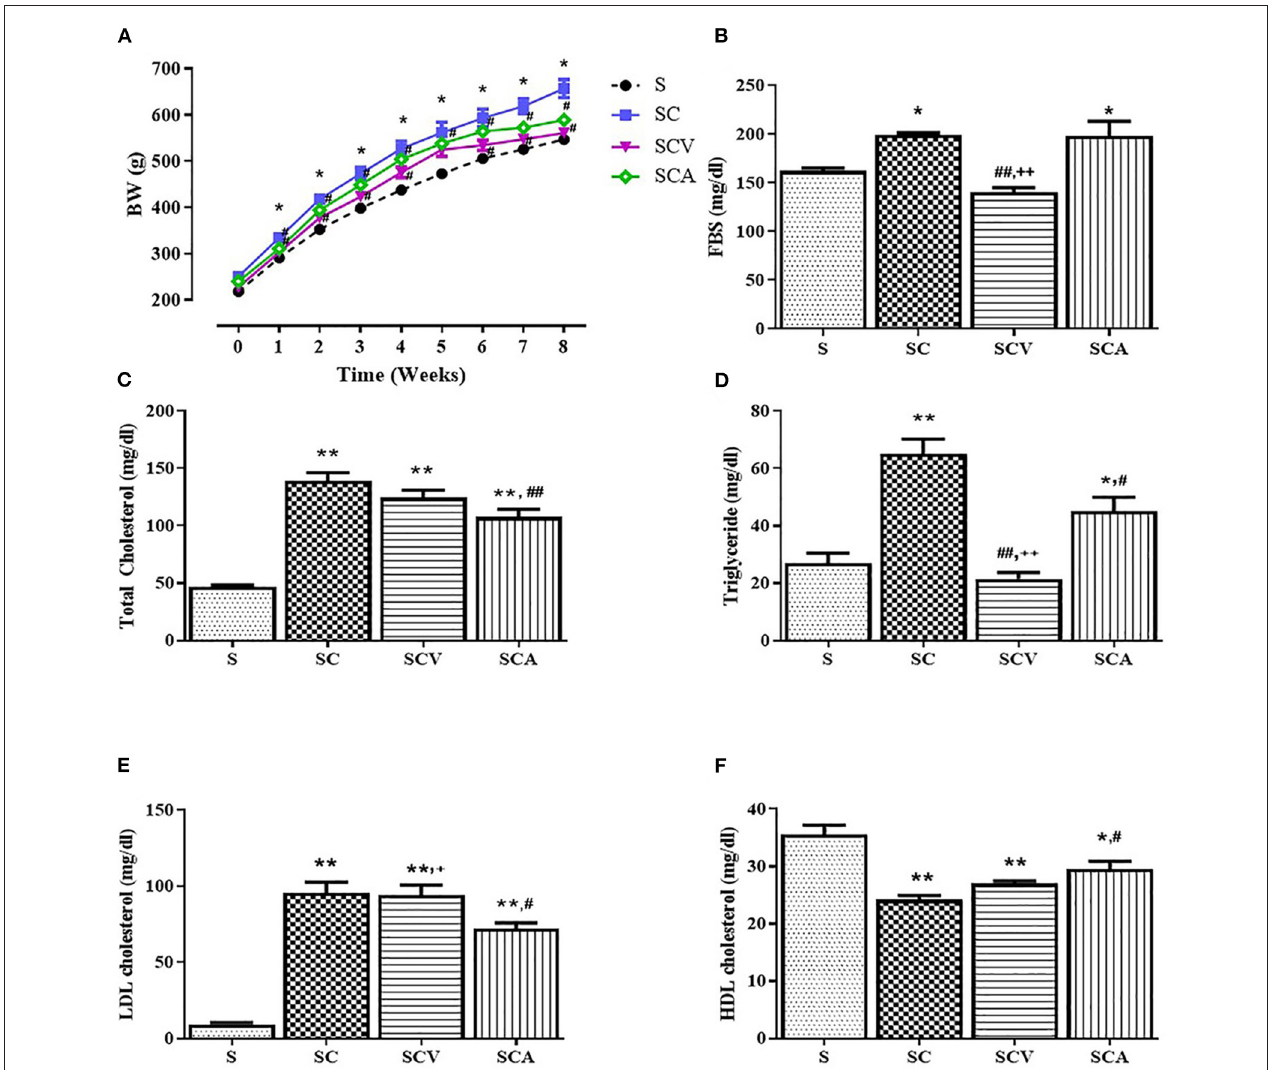
FIGURE 2 | Effect of coconut vinegar supplementation on metabolic parameters. (A) Body weight (BW); (B) Fasting blood sugar (FBS); (C) Total cholesterol; (D) Triglyceride; (E) LDL-cholesterol; (F) HDL-cholesterol. Each line or bar presented in mean ± SEM. * p < 0.05; ** p < 0.01 vs. the control group; # p < 0.05; ## p < 0.05 vs. the SC group; + p < 0.05; ++ p < 0.01 vs. the SCA group ( n = 6 per group).